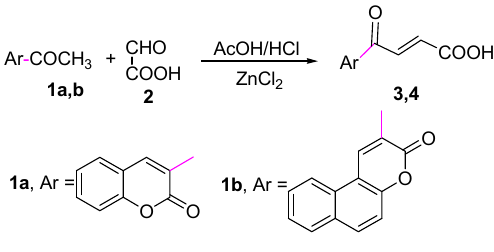
Scheme 1. Synthesis of compounds 3 and 4 .